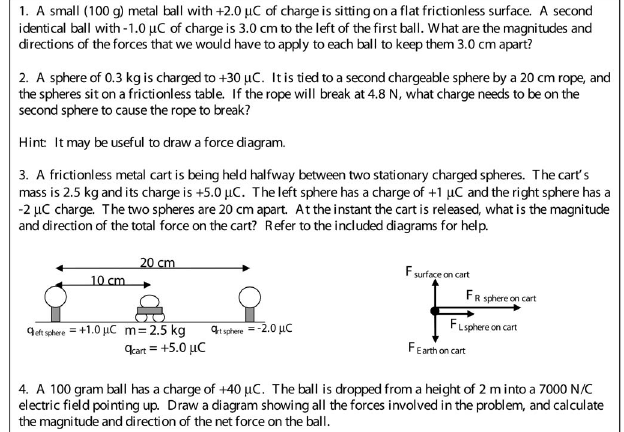
FIG. 1. Four problems given in recitation. Note the different prompts regarding multiple representation use (cid:3)(cid:1) 1 (cid:2) no prompt, (cid:1) 2 (cid:2) hint to draw a force diagram, (cid:1) 3 (cid:2) diagrams included, and (cid:1) 4 (cid:2) state- ment that diagrams are required (cid:4)